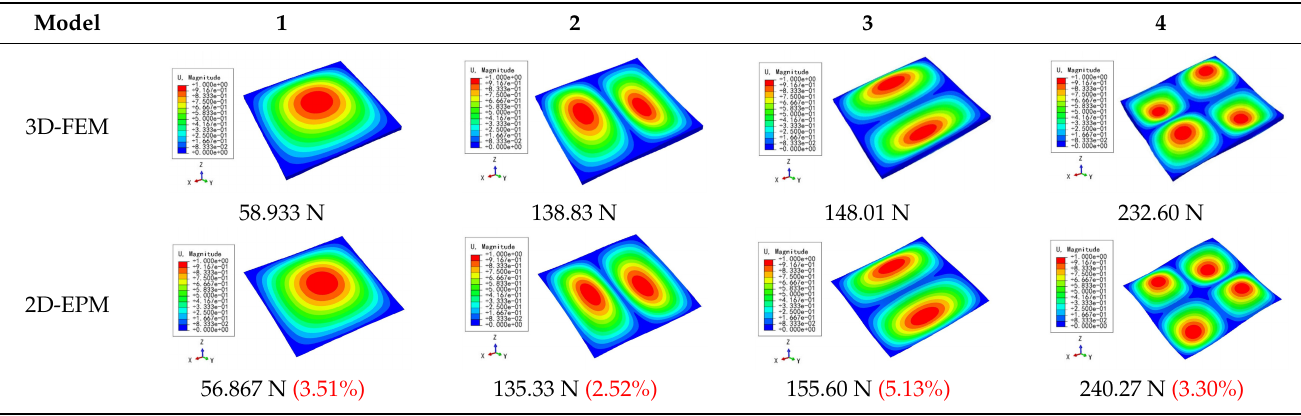
Table 12. Comparison of the buckling modes and buckling loads of the resized triangular HSP under SSSS boundary conditions predicted by different